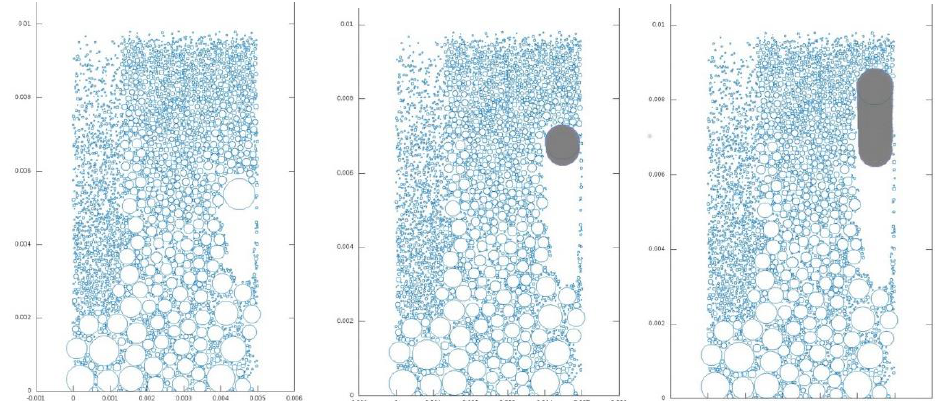
Figure 6. Droplet − rivulet transition, droplet distribution at three different time steps. From left to right: individual droplet running downstream, rivulet onset (grey area), rivulet development.